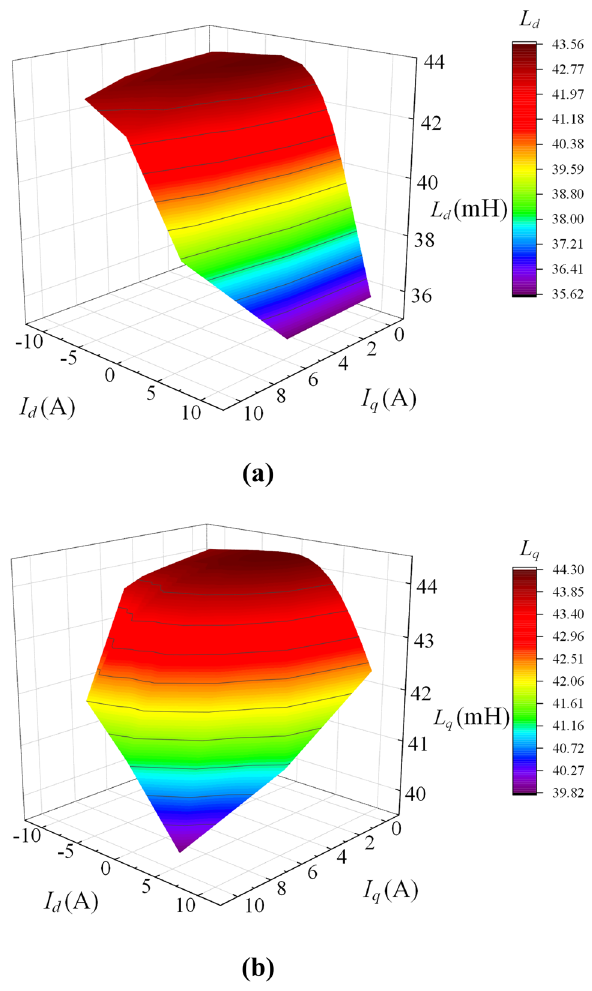
Figure 7. Influence of I d and I q on L d and L q . ( a ) Influence of I d and I q on L d , ( b ) influence of I d and I q on L q